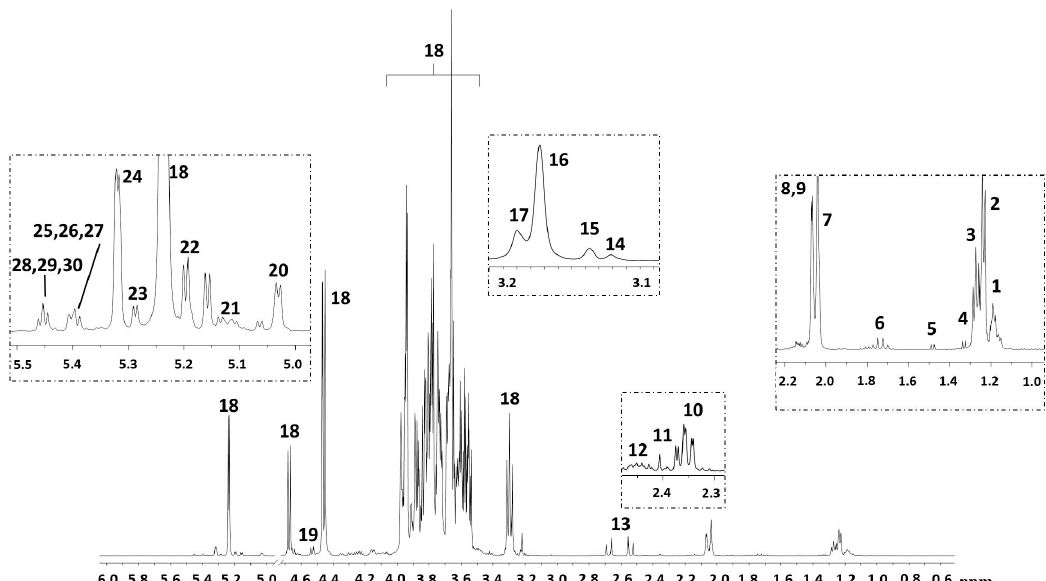
Figure 1. Representative nuclear magnetic resonance spectroscopy ( 1 H-NMR) spectra of human breast milk. Chemical shift attribution was performed according to the literature [5,6,9,10]. Keys: (1) H-6